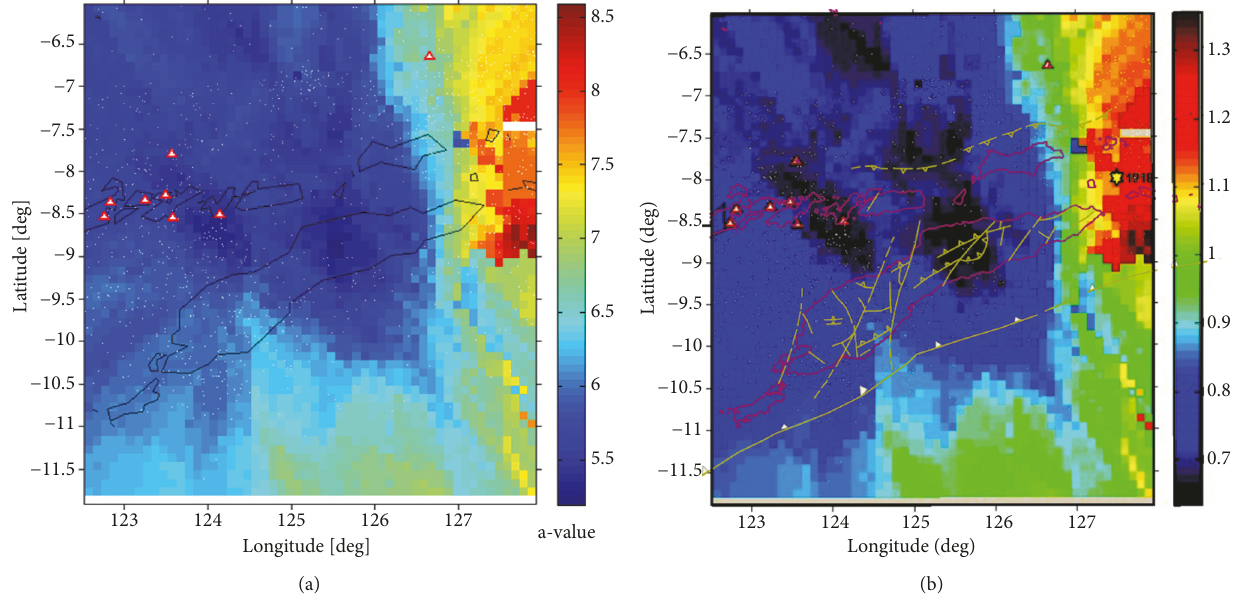
Figure 12: Spatial variation of seismicity of cluster 2 (Timor island, Alor island, and surrounding areas): (a) a-value and (b) b-value.